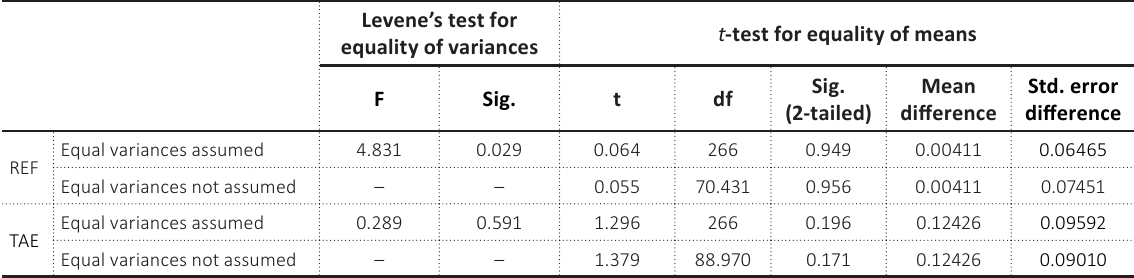
Table 7. Test results of the differences between 2 groups of